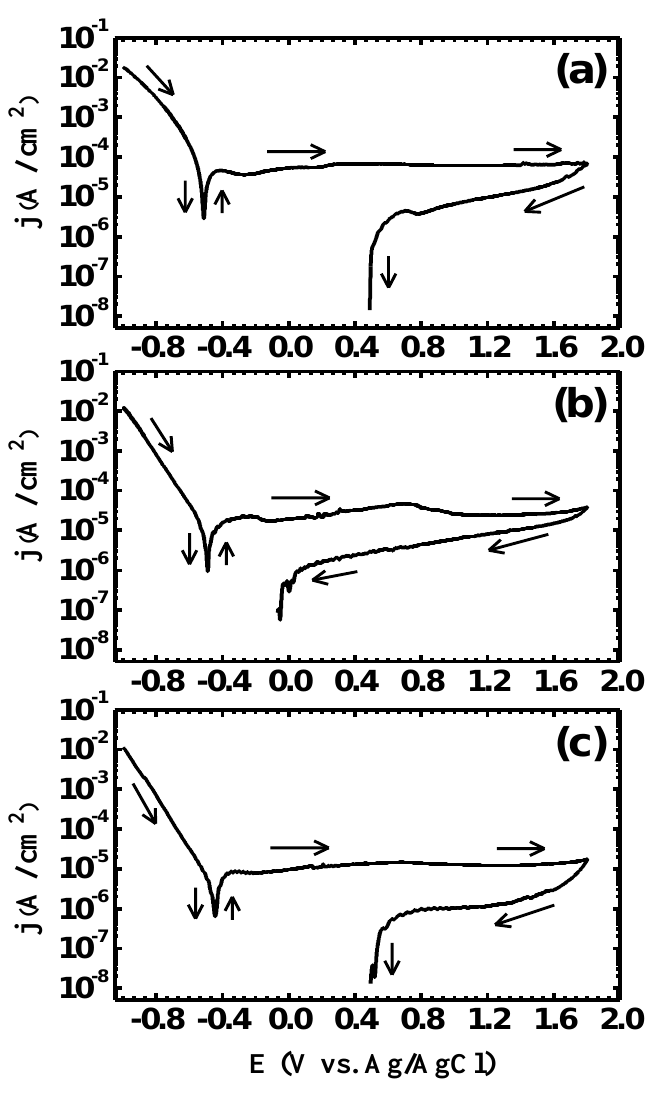
8 of 14 Figure 6. Cyclic potentiodynamic polarization curves obtained for ( a ) hot swaged; ( b ) annealed at 800 °C; and ( c ) annealed at 940 °C Ti-45M electrodes after their immersion for 1.0 h in 2 M HCl solutions. Moreover, the values of R Corr (milli-inches per year, mpy) were obtained using the following equation [25]: